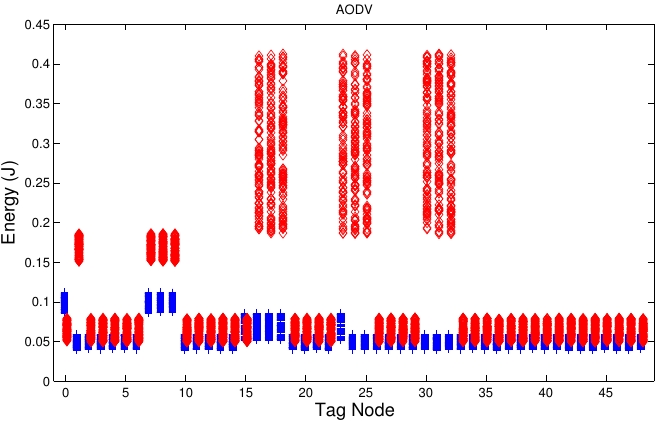
Figure 4. Energy consumption of the nodes from Figure 3 with AODV (Ad hoc On Demand Distance Vector) under normal (blue) and jamming (red) conditions.